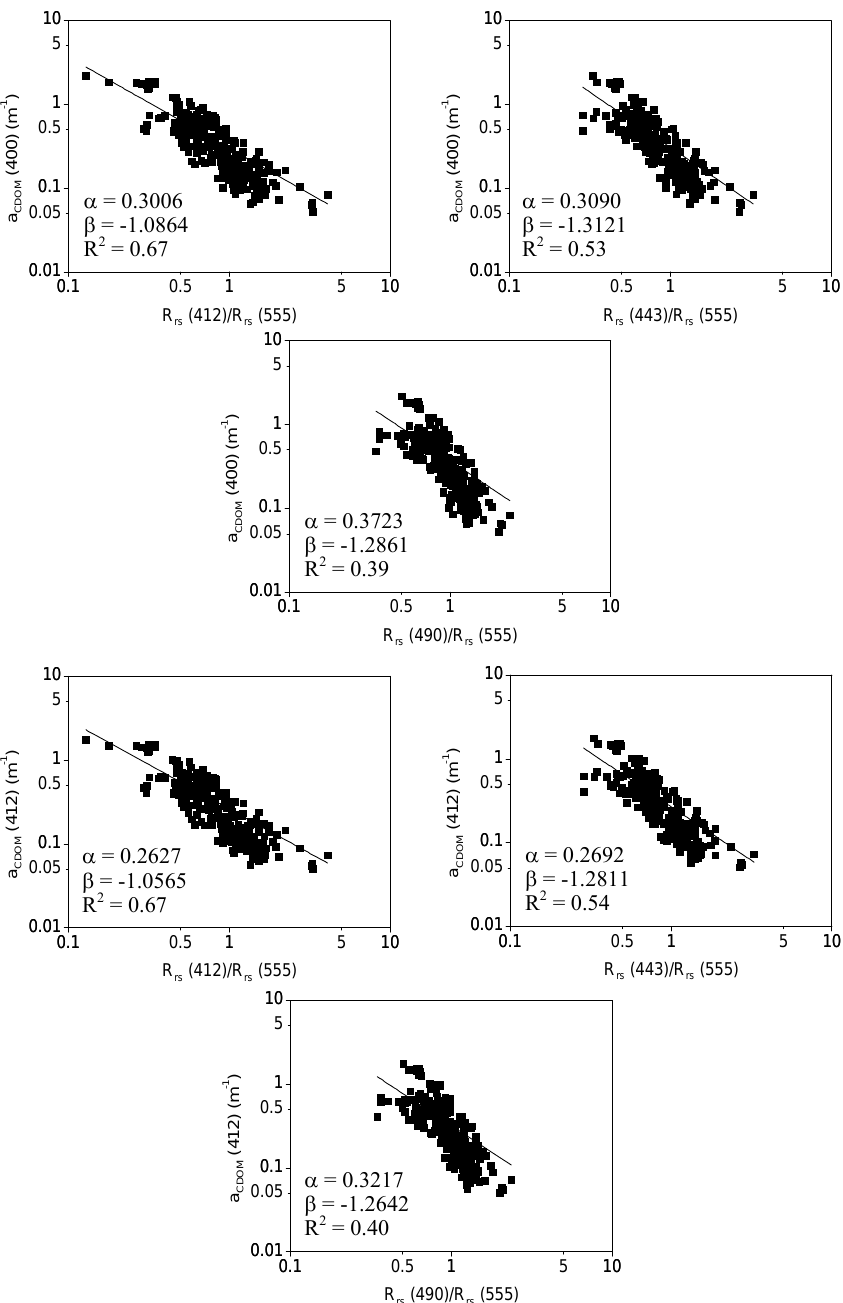
Fig. 3. Relationships between the three R rs ratios and a CDOM (400, 412) (m − 1 ) measured (in-situ) in a wide range of waters from the ECS, YS and KSS during 1998–2005 ( N